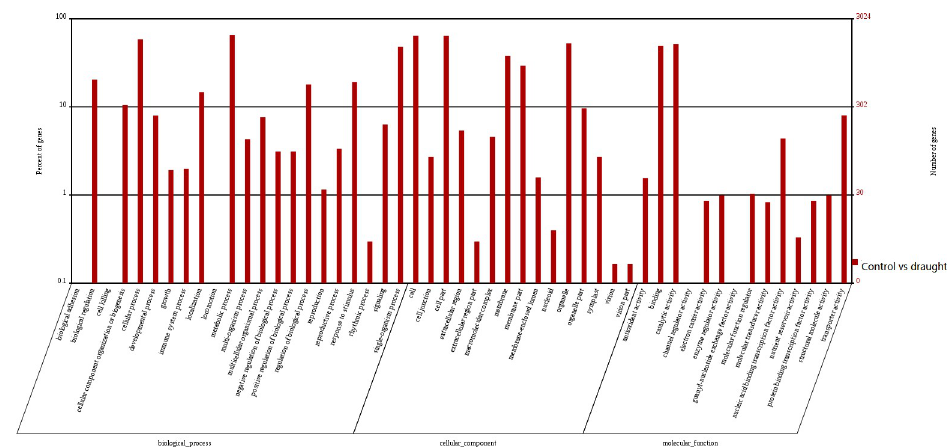
Fig 7. Description of the mapped KEGG pathways of the DEGs in Coix lacryma-jobi L. Left: The KEGG pathways; Right: the number of DEGs mapped into each KEGG pathway.